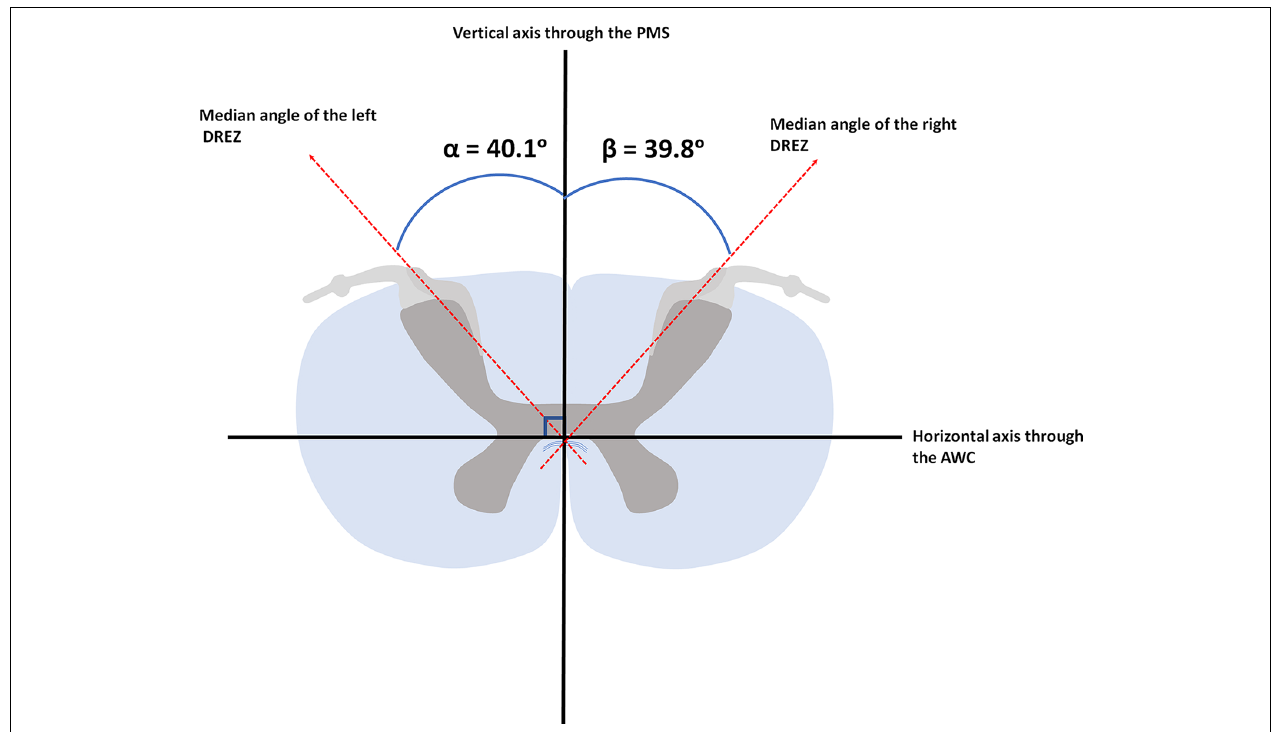
FIGURE 4 | Median angular measurements of the DREZ within the left and right dorsal root. AWC, anterior white commissure; PMS, posterior median sulcus.